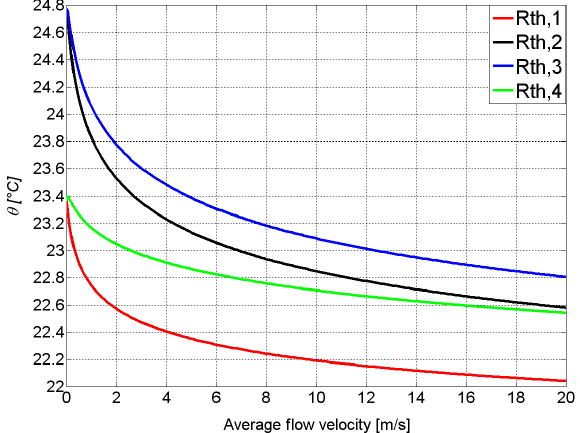
Figure 6. Simulated dependence of the thermistor temperatures (for design 1) on the flow velocity. The temperature of the incoming fluid and the ambient temperature were both set to 21 °C. The thermistors Th lines) and therefore show a higher initial temperature compared to the outmost thermistors (green and red lines). The efficiency of convective cooling decreases from Th hence the characteristics of Th the temperatures of the downstream thermistors Th their temperatures over their respective values at zero